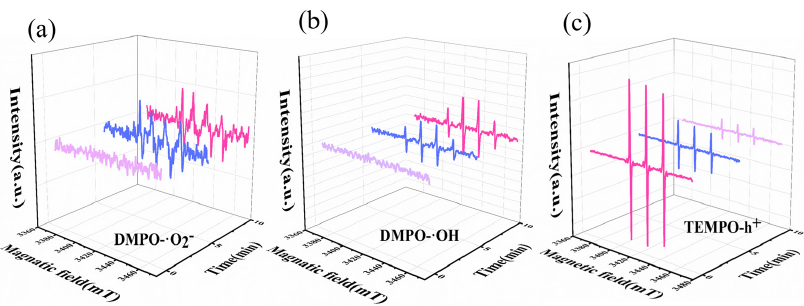
Figure 10. ( a – c ) Electron spin resonance spectra of various radical adducts.